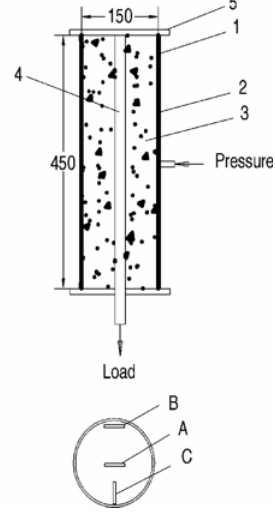
Fig 13 . The designed device to analyse the